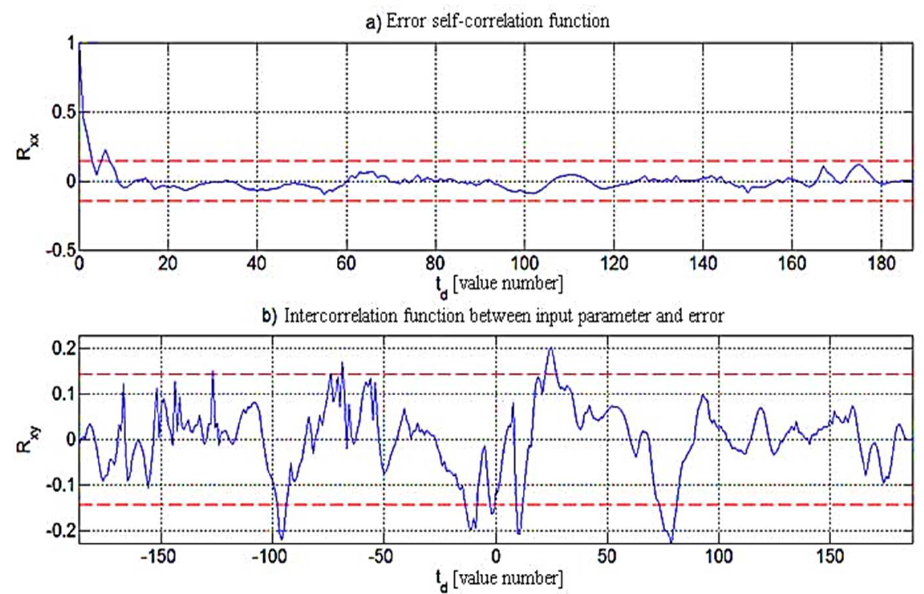
Figure 5. Simulation